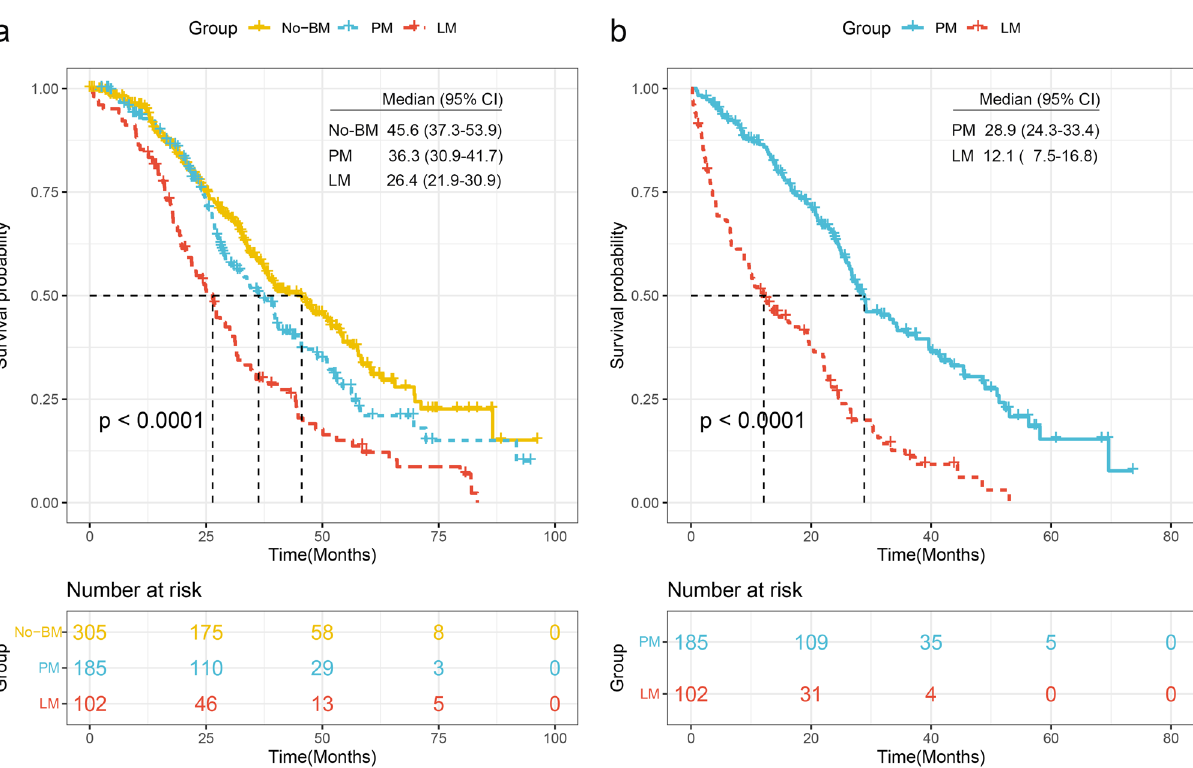
Figure 5. Survival. The survival curves calculated from the diagnosis of advanced NSCLC ( a ). The survival curves calculated from the diagnosis of PM and LM ( b